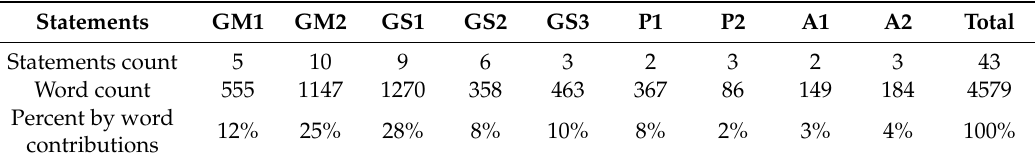
Table 6. Contributions to focus group by participant (as per